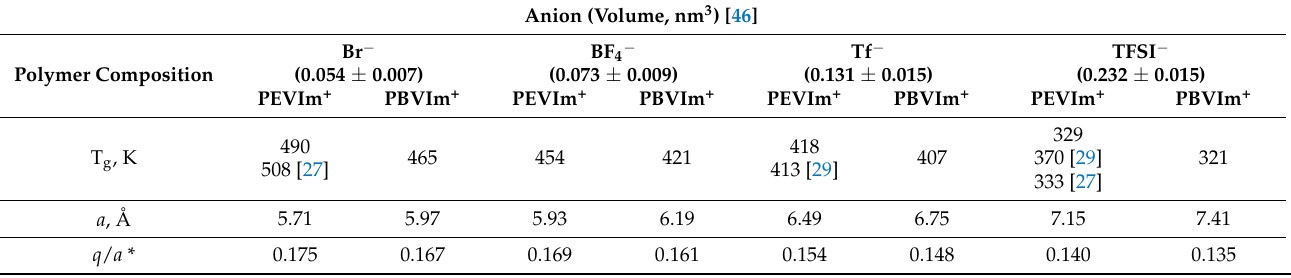
Table 1. T g of Poly(3-ethyl-1-vinylimidazolium) and Poly(3-butyl-1-vinylimidazolium) salts. [12]. Anion (Volume, nm 3 )